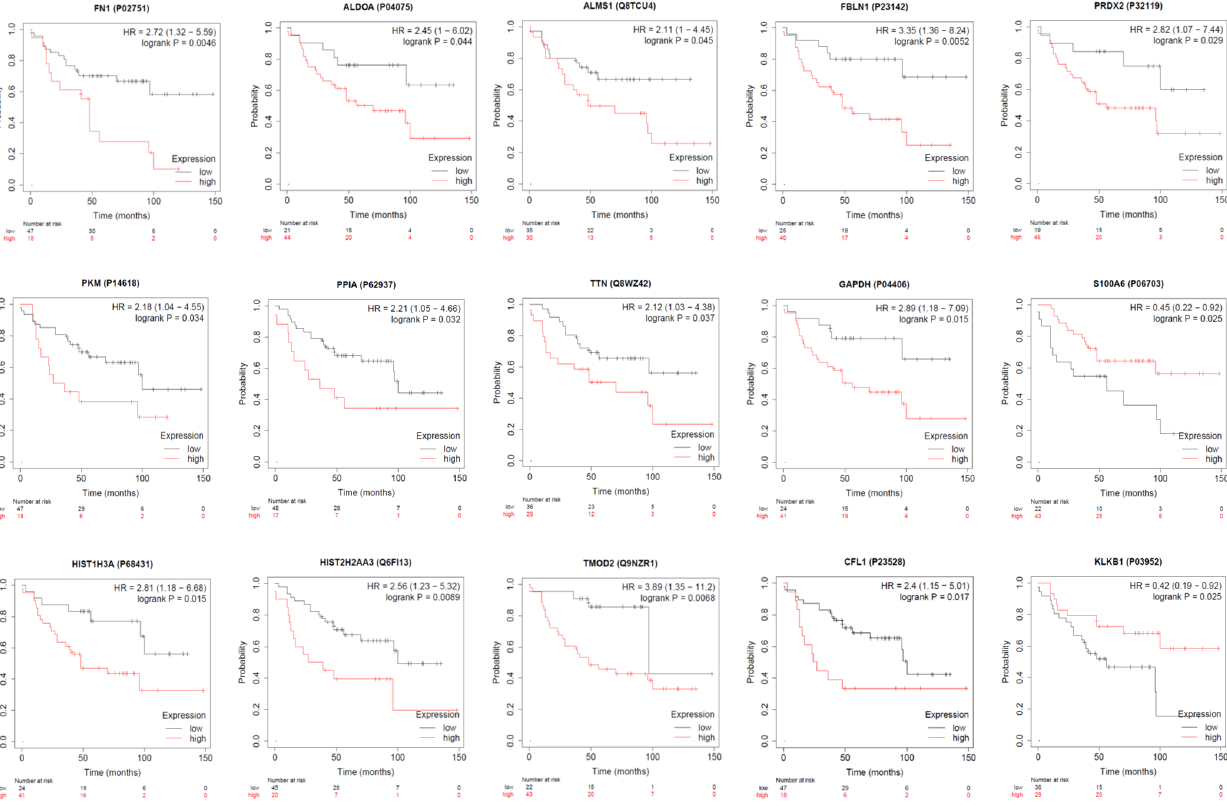
Figure 6. Kaplan Meier analyses showing the relationship between survival and breast tissue tumoral expression of EV associated proteins.